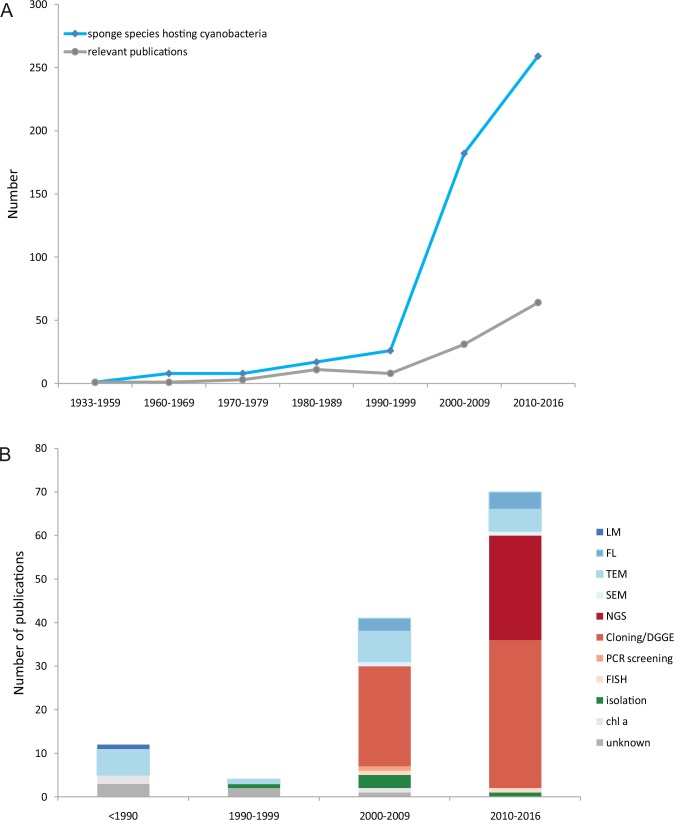
Sponge species hosting cyanobacteria recorded through time (A), and methods used for the investigation of cyanobacteria symbionts (B), in relation with research effort (i.e. number of publications).LM: Light microscopy, FL: Fluorescence microscopy, TEM: Transmission electron microscopy, SEM: Scanning electron microscopy, NGS: Next generation sequencing, DGGE: Denaturing gradient gel electrophoresis, FISH: Fluorescence in situ hybridization, chl a: chlorophyll a measurements.